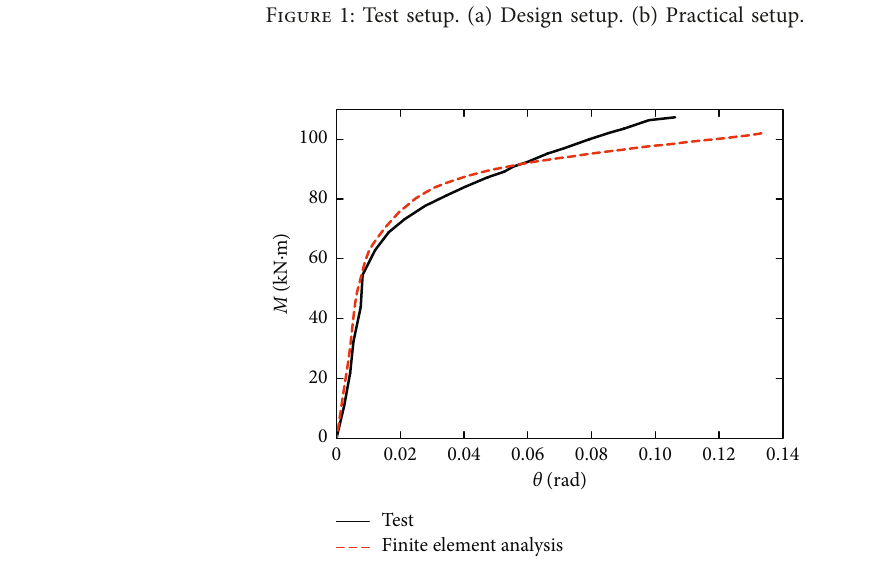
Figure 2: Comparison of the M - θ curve.